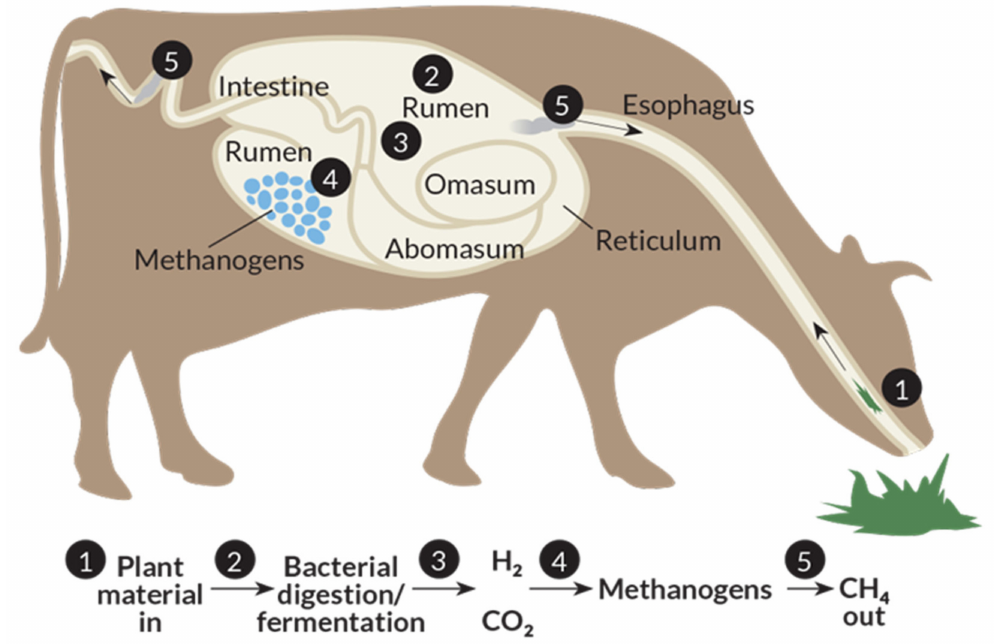
Figure 1. Processes of methane production in ruminants